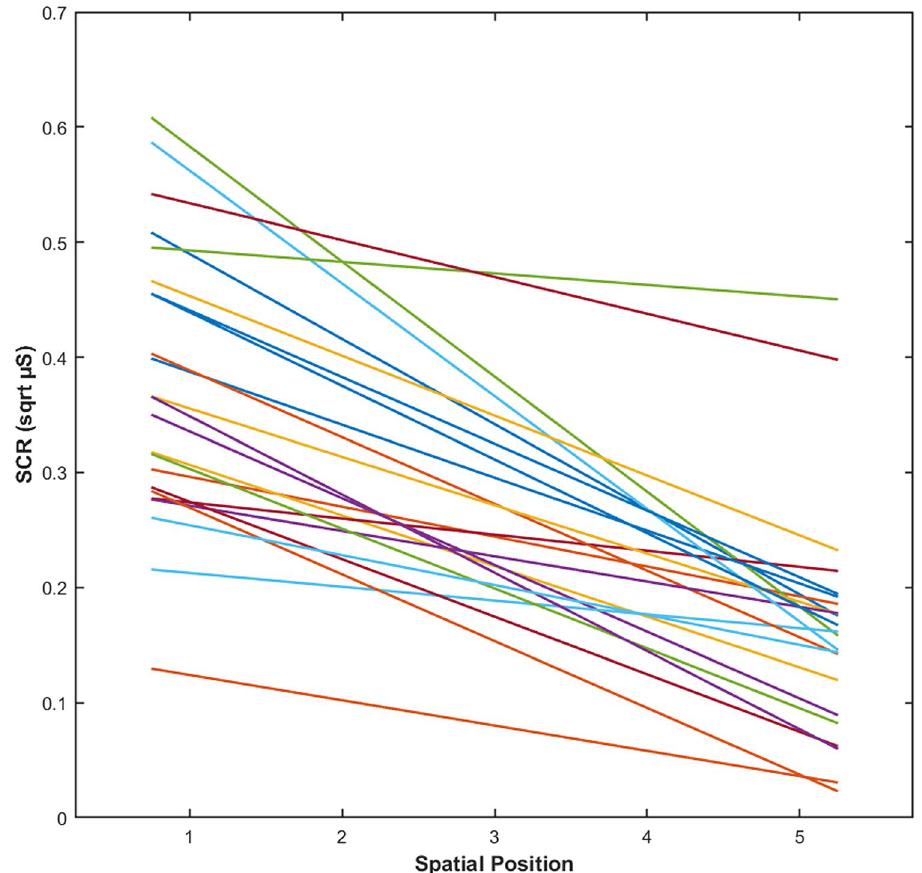
Figure 3. Relationship between preferred interpersonal distance and physiological measure. The graph depicts the best-fitting regression lines showing the relationship between SCR and spatial position in the approach condition of Experiment 1 for each individual participant (N = 23). The slope of each line, indicating the rate at which SCR changed as the confederate approached the participant, were correlated with participants’ preferred interpersonal distance, as assessed in the comfort-distance task of Experiment